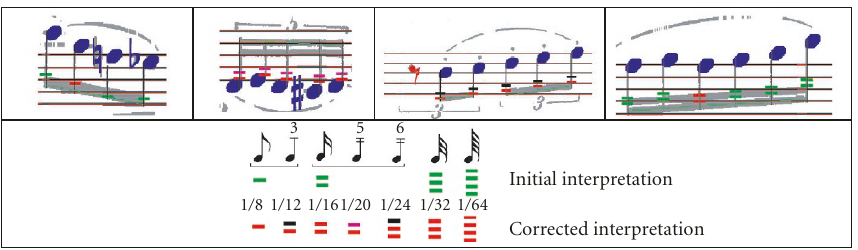
Figure 16: Examples of groups with length correctly interpreted thanks to Rule (5). In red the lengths that were not correct after the beam counting process . In the second bar, for example, the notes initially interpreted as semiquavers (1 / 16) are corrected into a quintuplet of semiquavers (1 /